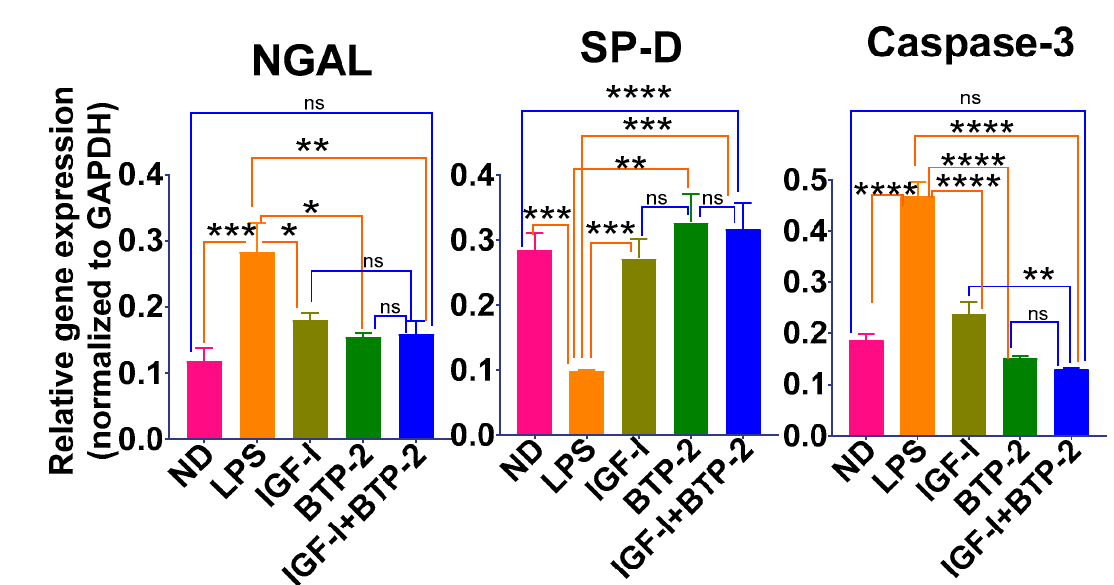
Figure 5. Effects of the IGF—I and BTP—2 monotherapies and the IGF—I + BTP—2 combination therapy on LPS of the injury and repair markers in the lungs. Day 7 RT—qPCR for the injury markers NGAL and caspase-3 and repair marker SP—D. Data are the mean ± SEM. * p < 0.05, ** p < 0.01, *** p < 0.001, **** p < 0.0001 and ns—no significance. One-way ANOVA, followed by Bonferroni’s multiple comparisons test.